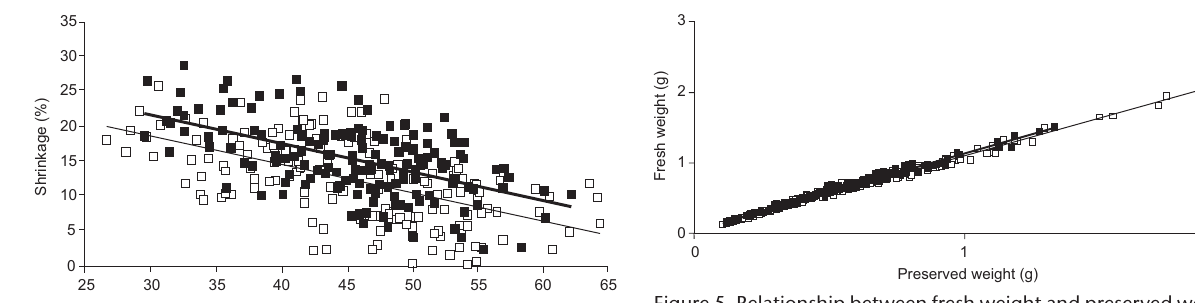
0.96).Figure Figure 6. Relationship between fresh total length and preserved total length for A. brasiliensis : freshwater ( (cid:133) ) (y = 0.9588x + 5.8437, R 2 = 0.981); marine water ( (cid:132) ) (y = 0.8621x + 10.425, R 2 =